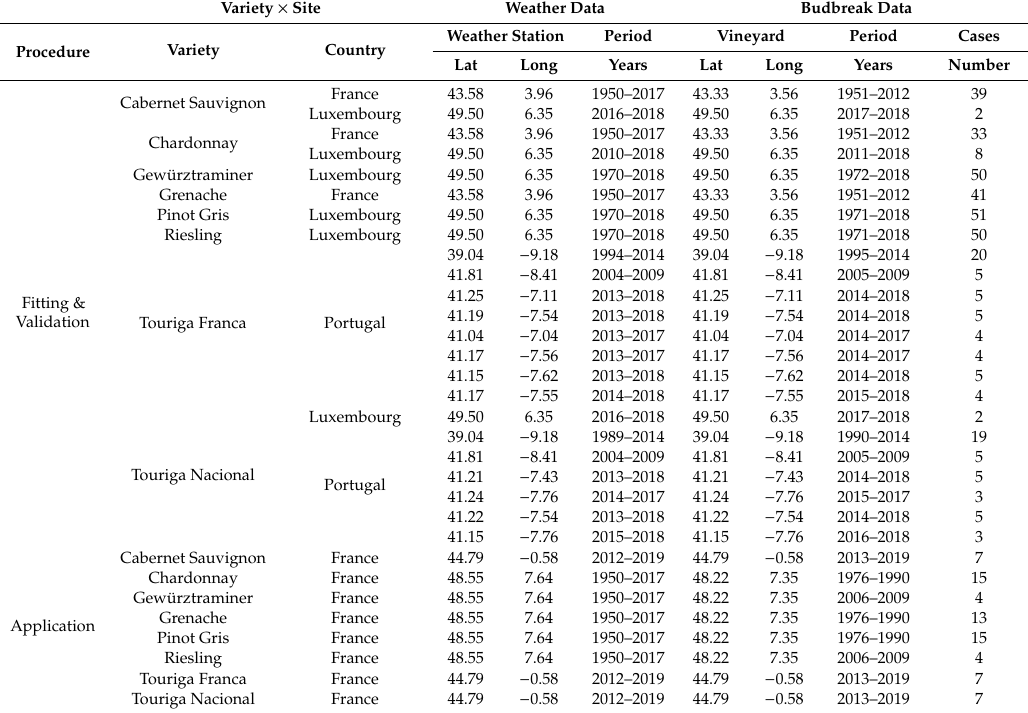
Table 1. Observed weather (daily maximum and minimum air temperature, ◦ C) and budbreak data of eight grapevine varieties used for model fitting, validation and application in di ff erent locations across Europe. The geographical positions of all weather stations and vineyards are identified with the latitude (Lat) and longitude (Long) coordinates